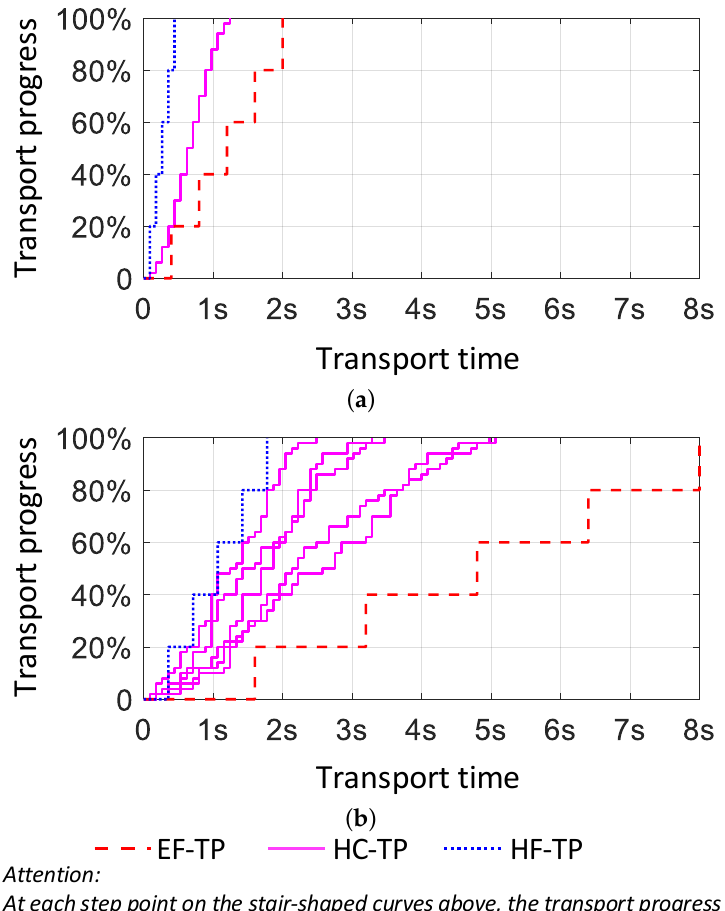
Figure 10. Transport progress in permanent route interruption. ( a ) Single flow in one route. ( b ) Multiple flow-sharing